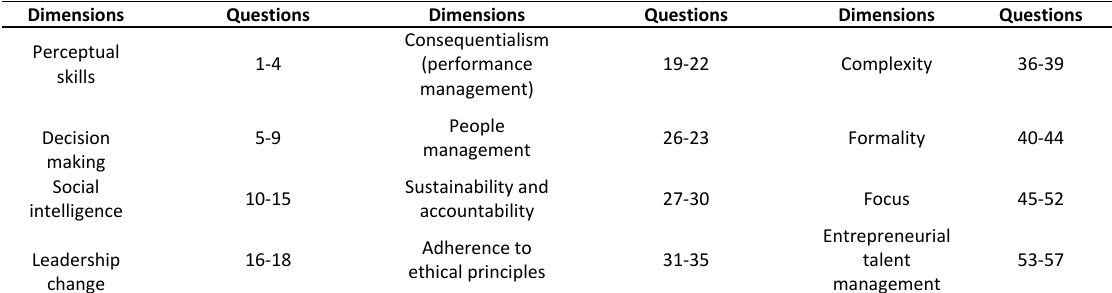
Table 3. The relationships between variables based on the elements of the questionnaire